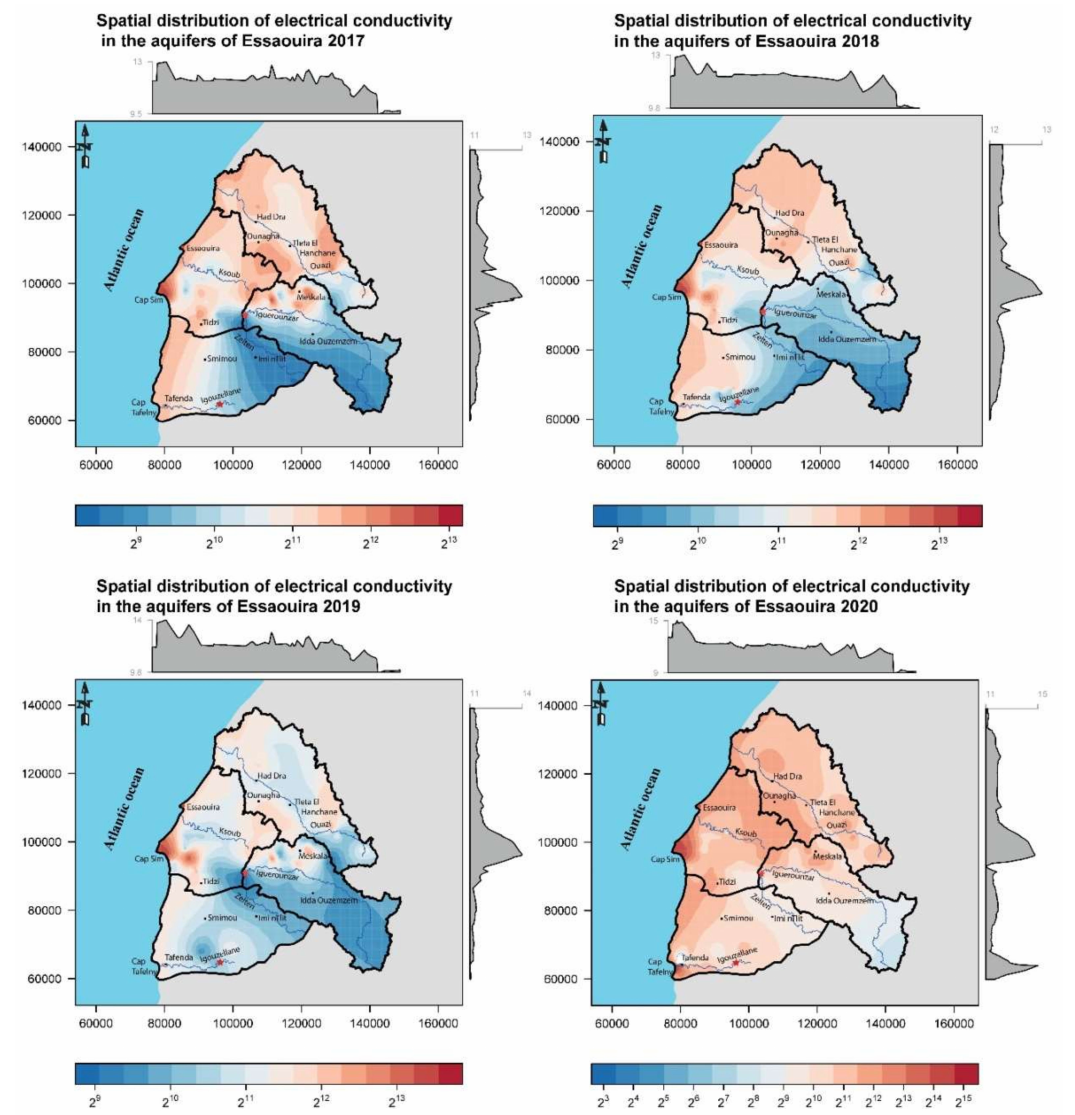
Figure 10. Spatial distribution of electrical conductivity in Essaouira’s aquifers between 2017 and 2020.